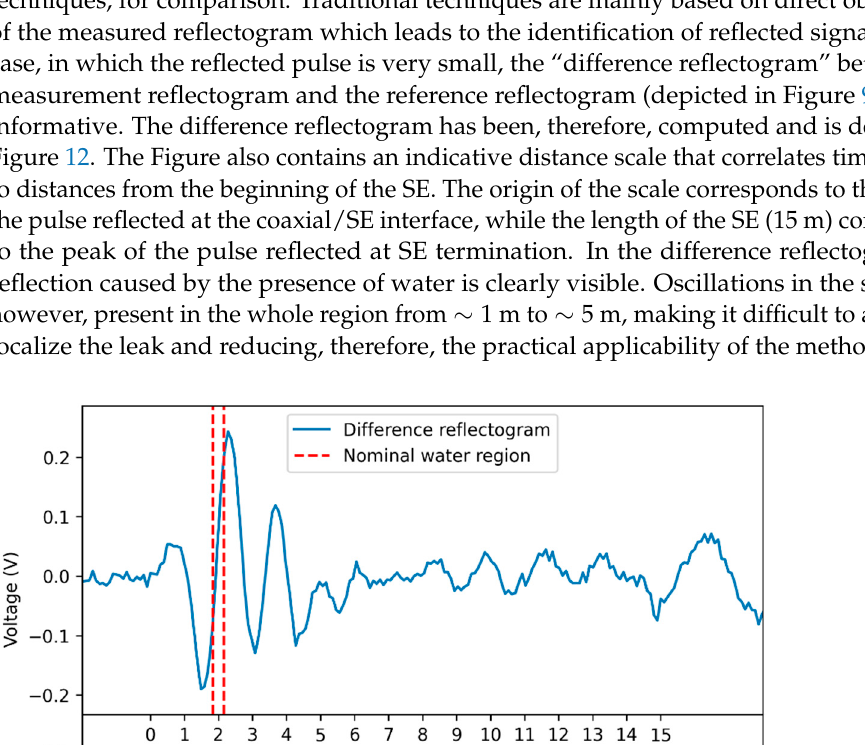
Table 1. Estimation results for the water leak position and entity estimation in the case of leak length 33.5 cm.